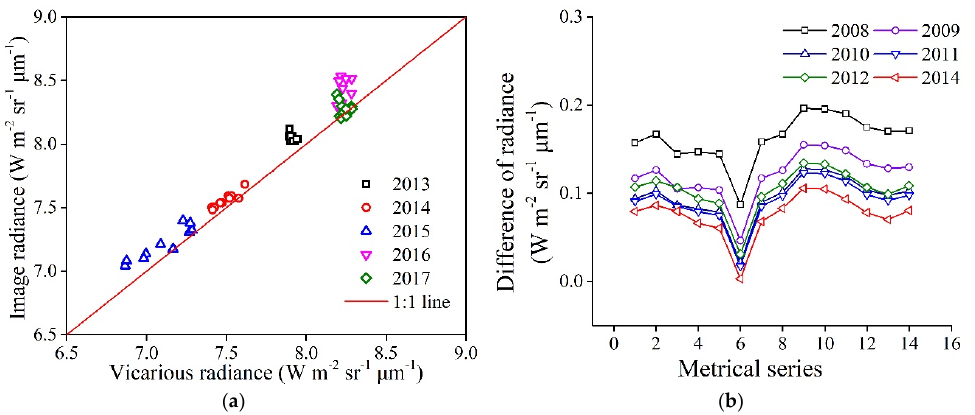
Figure 8. ( a ) Plot of radiance predicted at sensor versus measured vicarious radiance for the IRS; ( b ) difference of top-of-atmosphere (TOA) radiance by different calibration coefficients (2014). ( b ) di ff erence of top-of-atmosphere (TOA) radiance by di ff erent calibration coe ffi cients